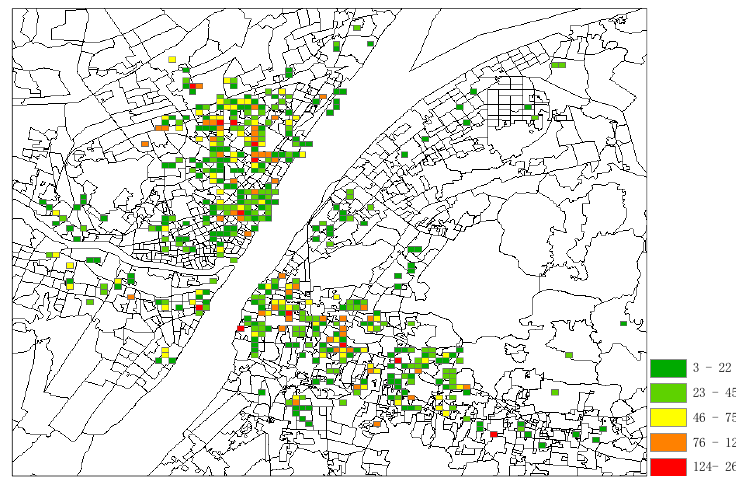
Figure 8. Visiting Intensities of All Suspects.